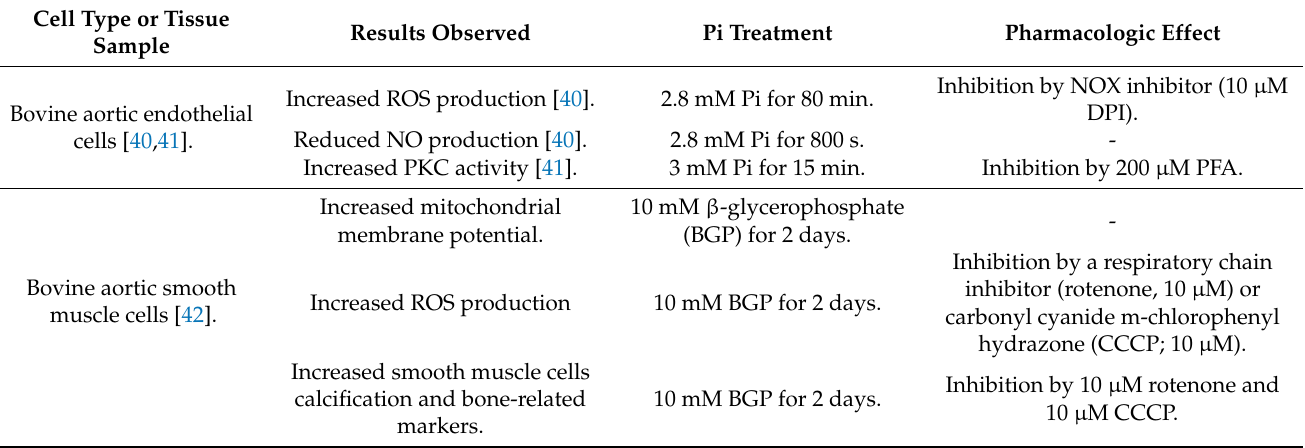
Table 4. Pi-induced ROS production is a possible risk factor for cardiovascular